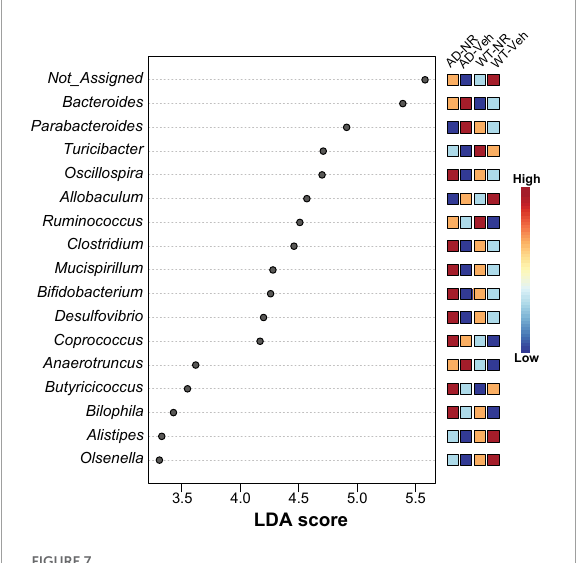
FIGURE7 Potential microbiome biomarker of NR treatment on Alzheimer’s disease (AD) mice at the genus level. The Linear discriminant analysis (LDA) effect size (Lefse) scores were computed for features differentially abundant between groups. Here we showed the top 15 most significant biomarkers ( P < 0.001). The right heatmap shows the relative abundance (log 10 transformation) of operation taxonomic units (OTUs). The left histogram shows the featured microbiome biomarker at the genus level. WT-Veh (4 males and 1 female), WT-NR (4